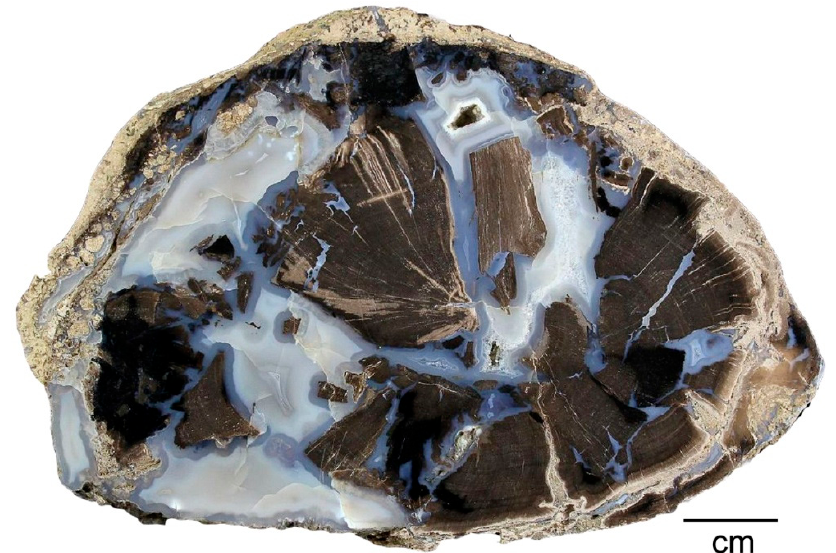
Figure 19. Banded chalcedony filling shrinkage cracks and decayed areas in a Blue Forest limb.